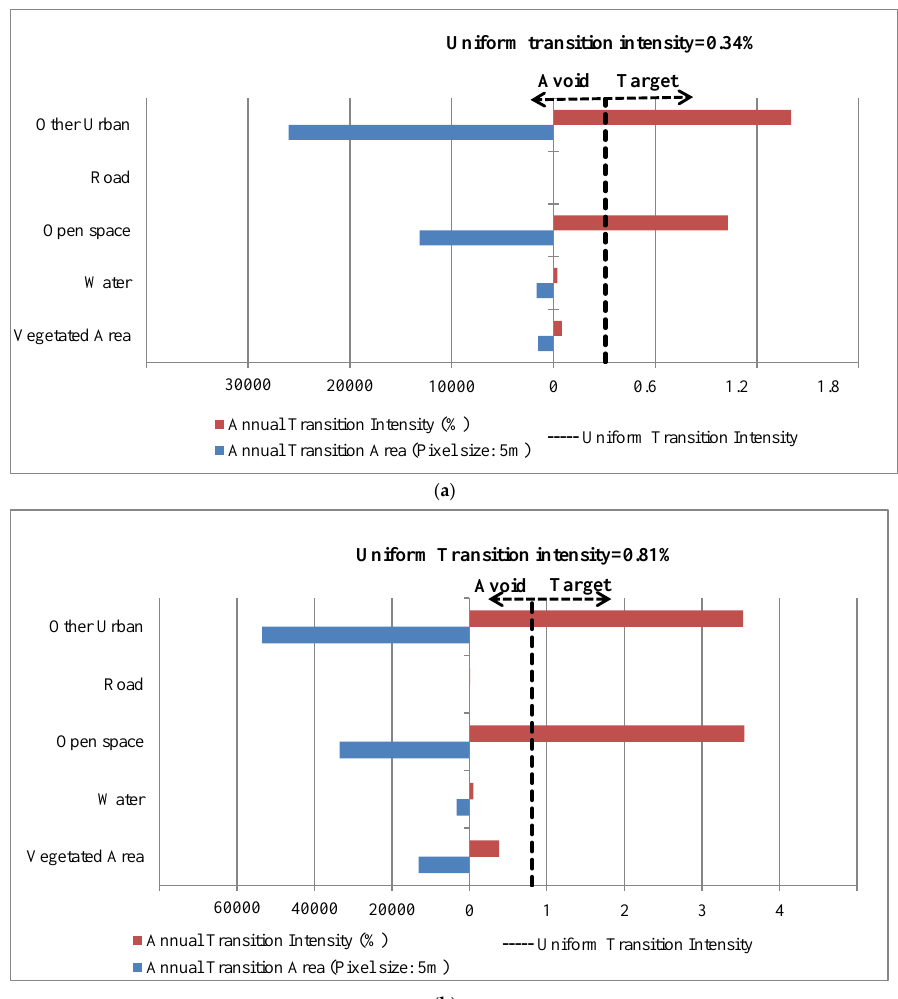
Figure 11. ( a ) Transition intensity analysis “from” slum (2009–2015); and ( b ) transition intensity analysis “to” slum (2009–2015).